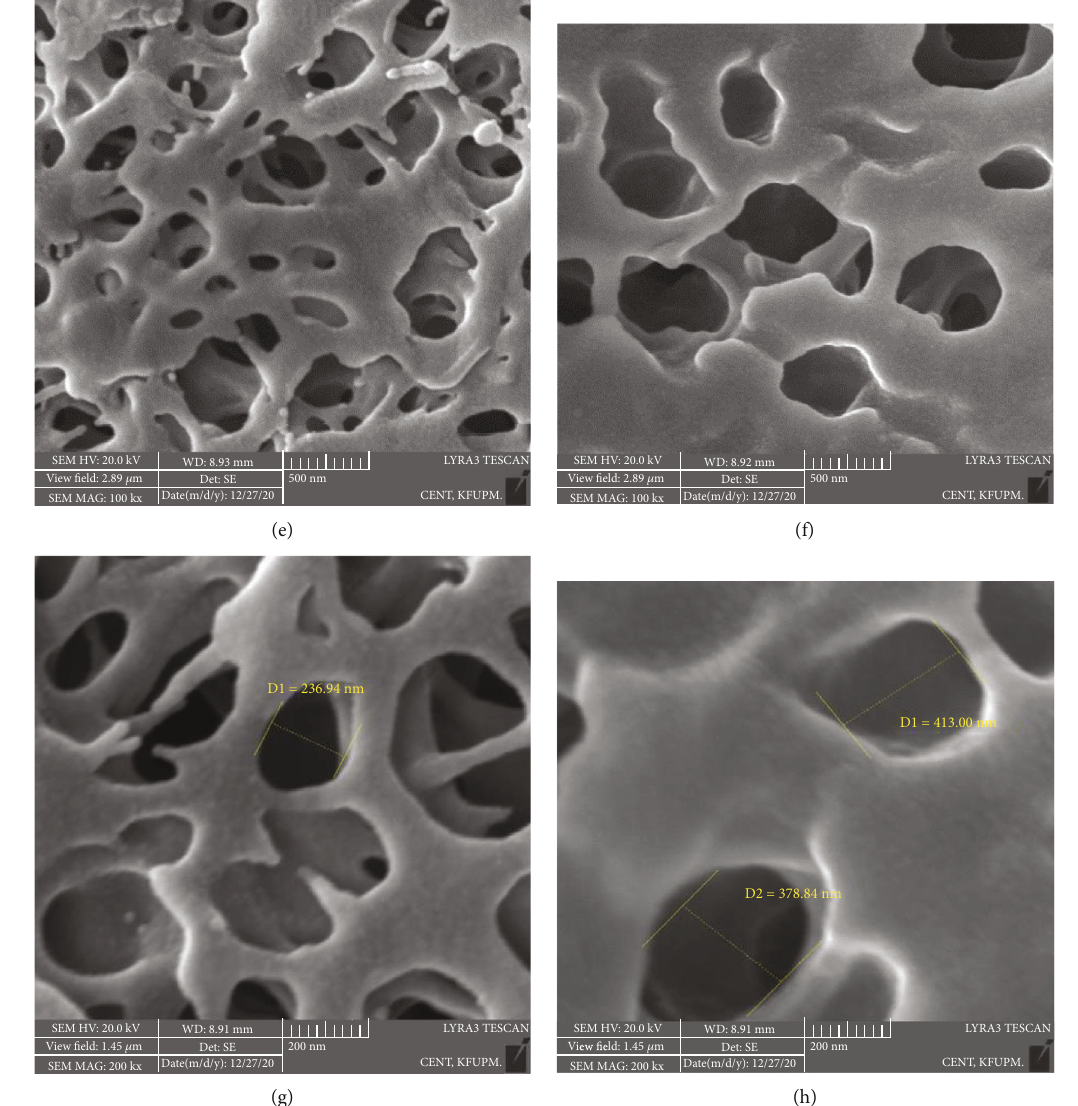
Figure 3: Scanning electron micrograph at magni fi cations 10x (a) unused and (b) used; 50x (c) unused and (d) used; 100x (e) unused and (f) used; and 200x (g) unused and (h)